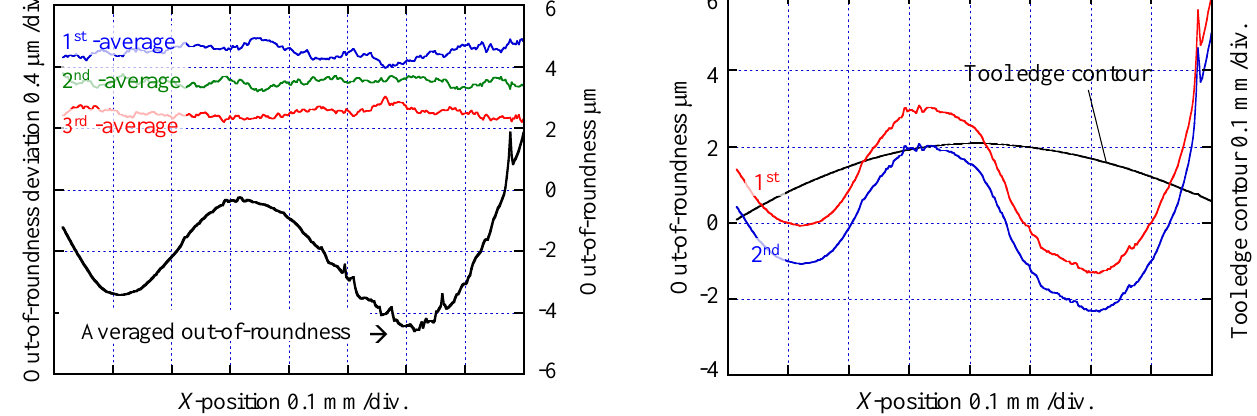
Figure 16. Out-of-roundness measured by the direct-scan method.